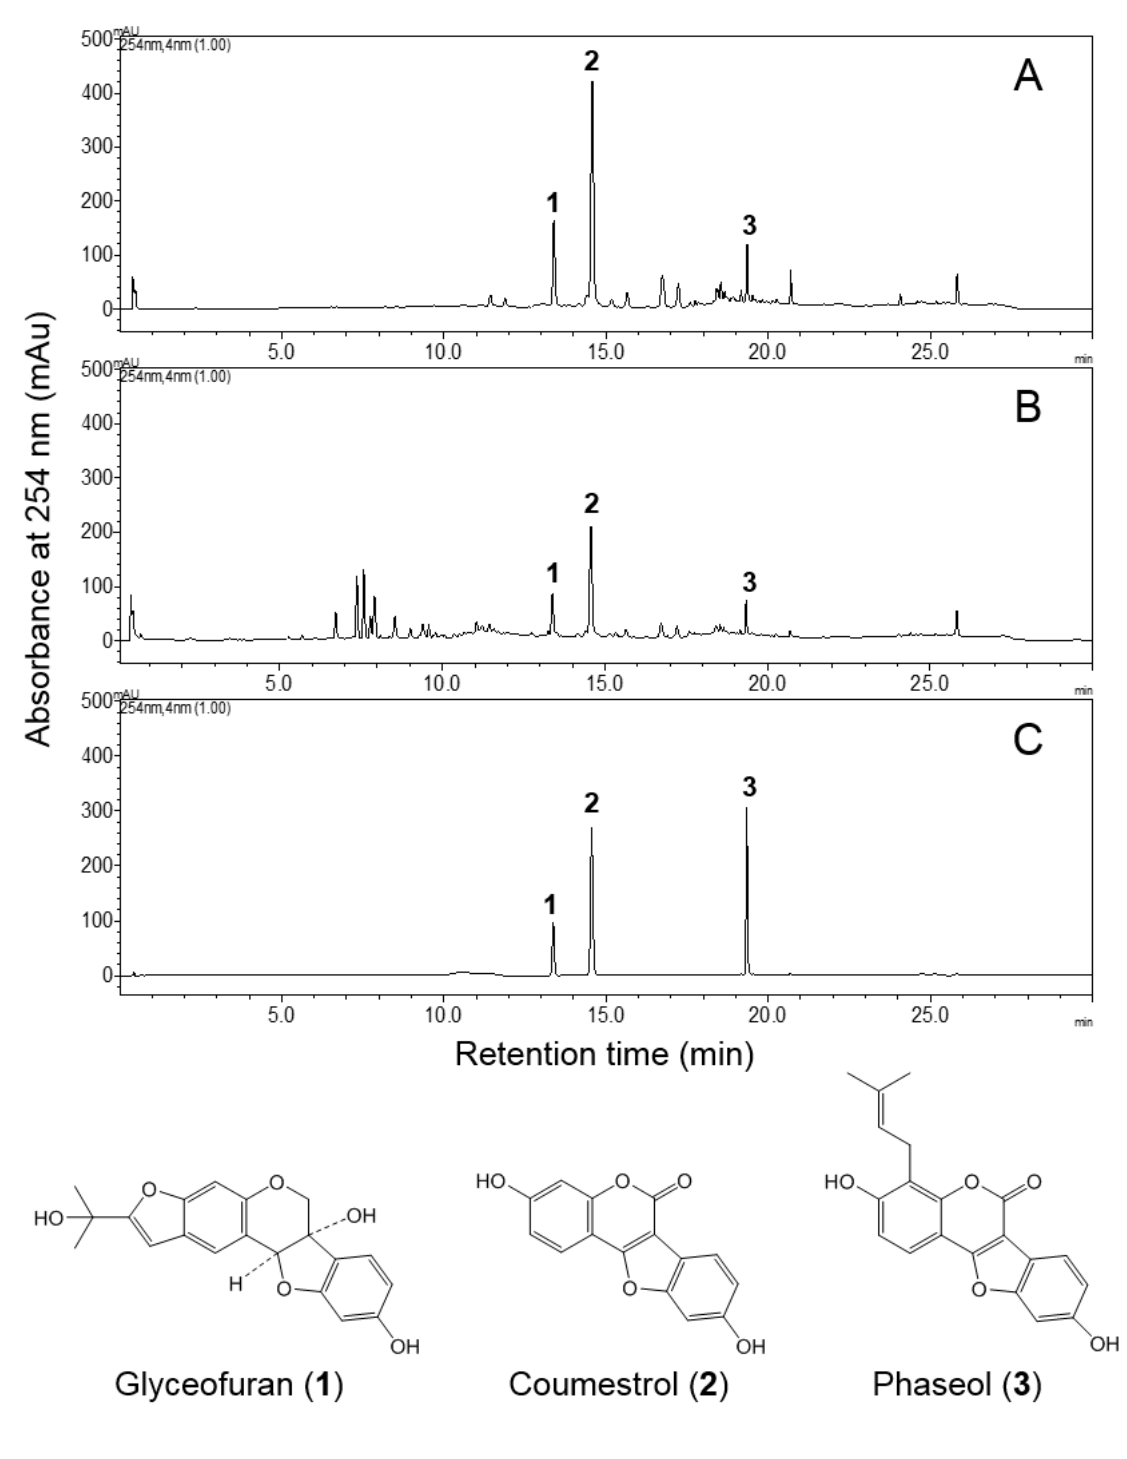
Figure 5. HPLC chromatograms of EASL ( A ), 95% EtOH extract ( B ) from soy leaves, and the external standards 1 , 2 , and 3 ( C ) and their chemical structures. The HPLC chromatograms were detected at 254 nm. Peaks: 1 , glyceofuran (T R : 13.36 min); 2 , coumestrol (T R : 14.55 min); and 3 , Phaseol (T R : 19.33 min). The mean peak areas of 1 , 2 , and 3 were 12.5%, 36.6%, and 5.4%, respectively, in EASL; the mean peak areas of 1 , 2 , and 3 were 6.2%, 19.5%, and 3.3%, respectively, in 95% ethanol